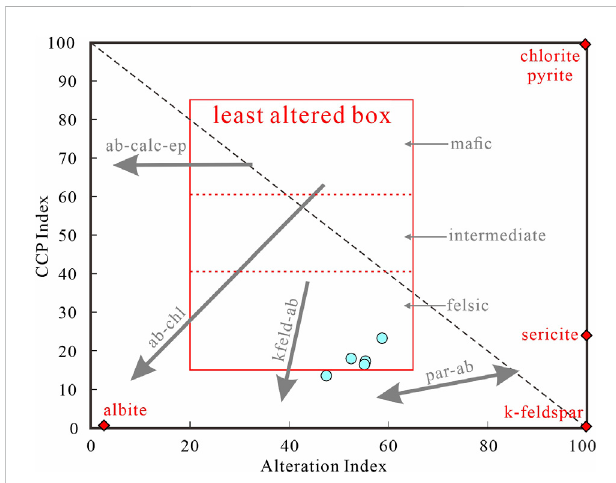
FIGURE 9 Alteration box plot with fi elds of diagenetic alteration (Large et al., 2001). The arrows show the common trends for diagenetic alteration. Abbreviations: ab-calc-ep, epidote – calcite ± albite trend; ab-chl, albite – chlorite trend; k-feld-ab, early diagenetic trend of K-feldspar replacing albite; par-ab, sericite – albite trend.